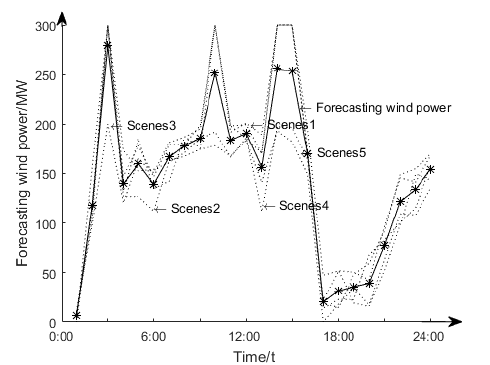
Figure 2. Wind power forecast output